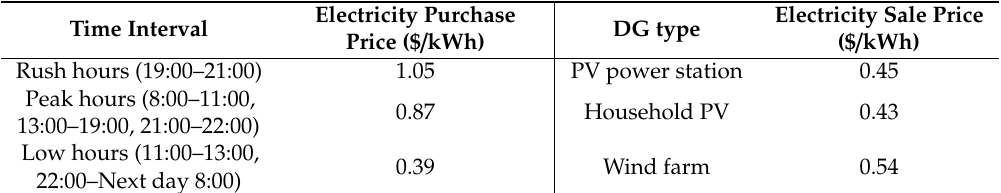
Table 2. Time-of-day tari ff data.